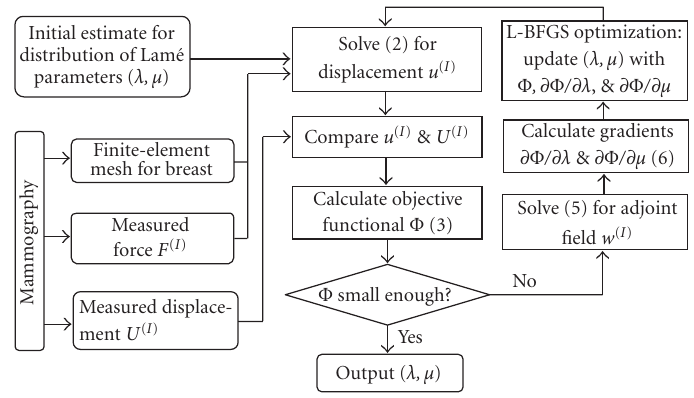
Figure 1: Overall flowchart for elasto-mammography reconstruction of Lam´e parameters λ and μ of breast